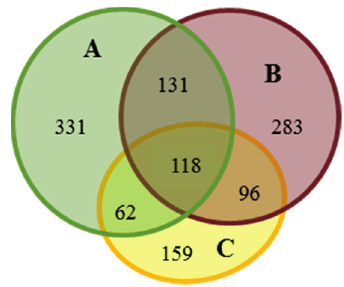
Figure 3. Venn diagram of protein spot assignment, which expressed in the three characteristics of explants that derived from Fraxinus mandshurica immature zygotic embryo cotyledons. ( A ) non-browned explants without somatic embryos (NBNSE); ( B ) browned explants with somatic embryos (BSE); and ( C ) browned explants without somatic embryos (BNSE).